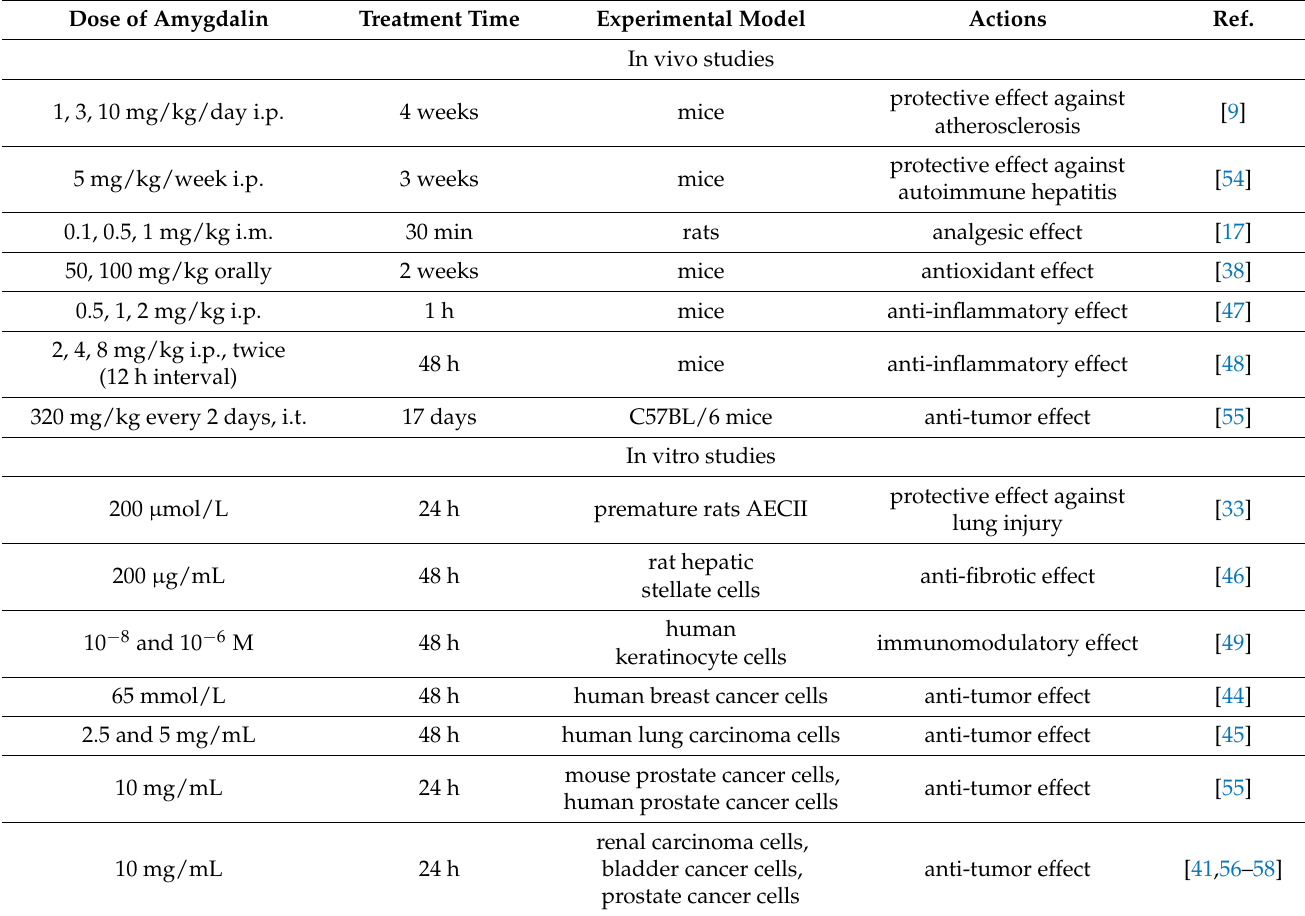
Table 1. Physiological and therapeutic actions of